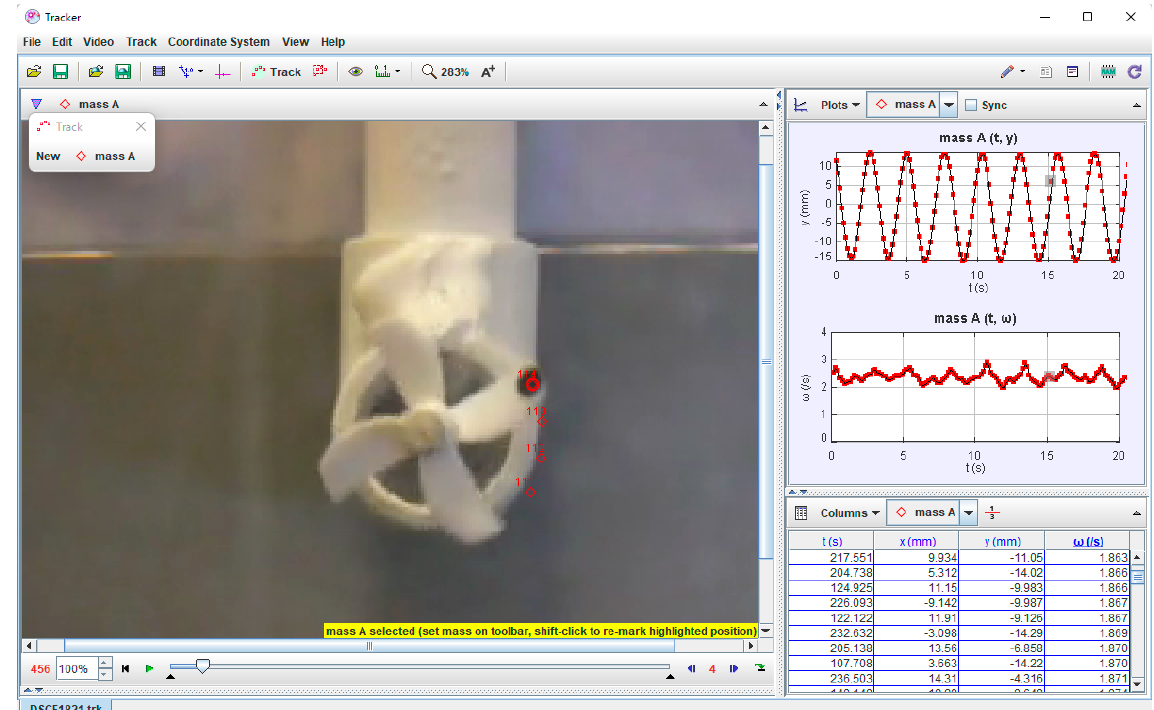
Figure 2. Experimental setup: ( A ) a snapshot of the experimental setup, ( B ) Elements of the experimental setup, ( C ) side view of the rotor, ( D ) front view of the rotor.